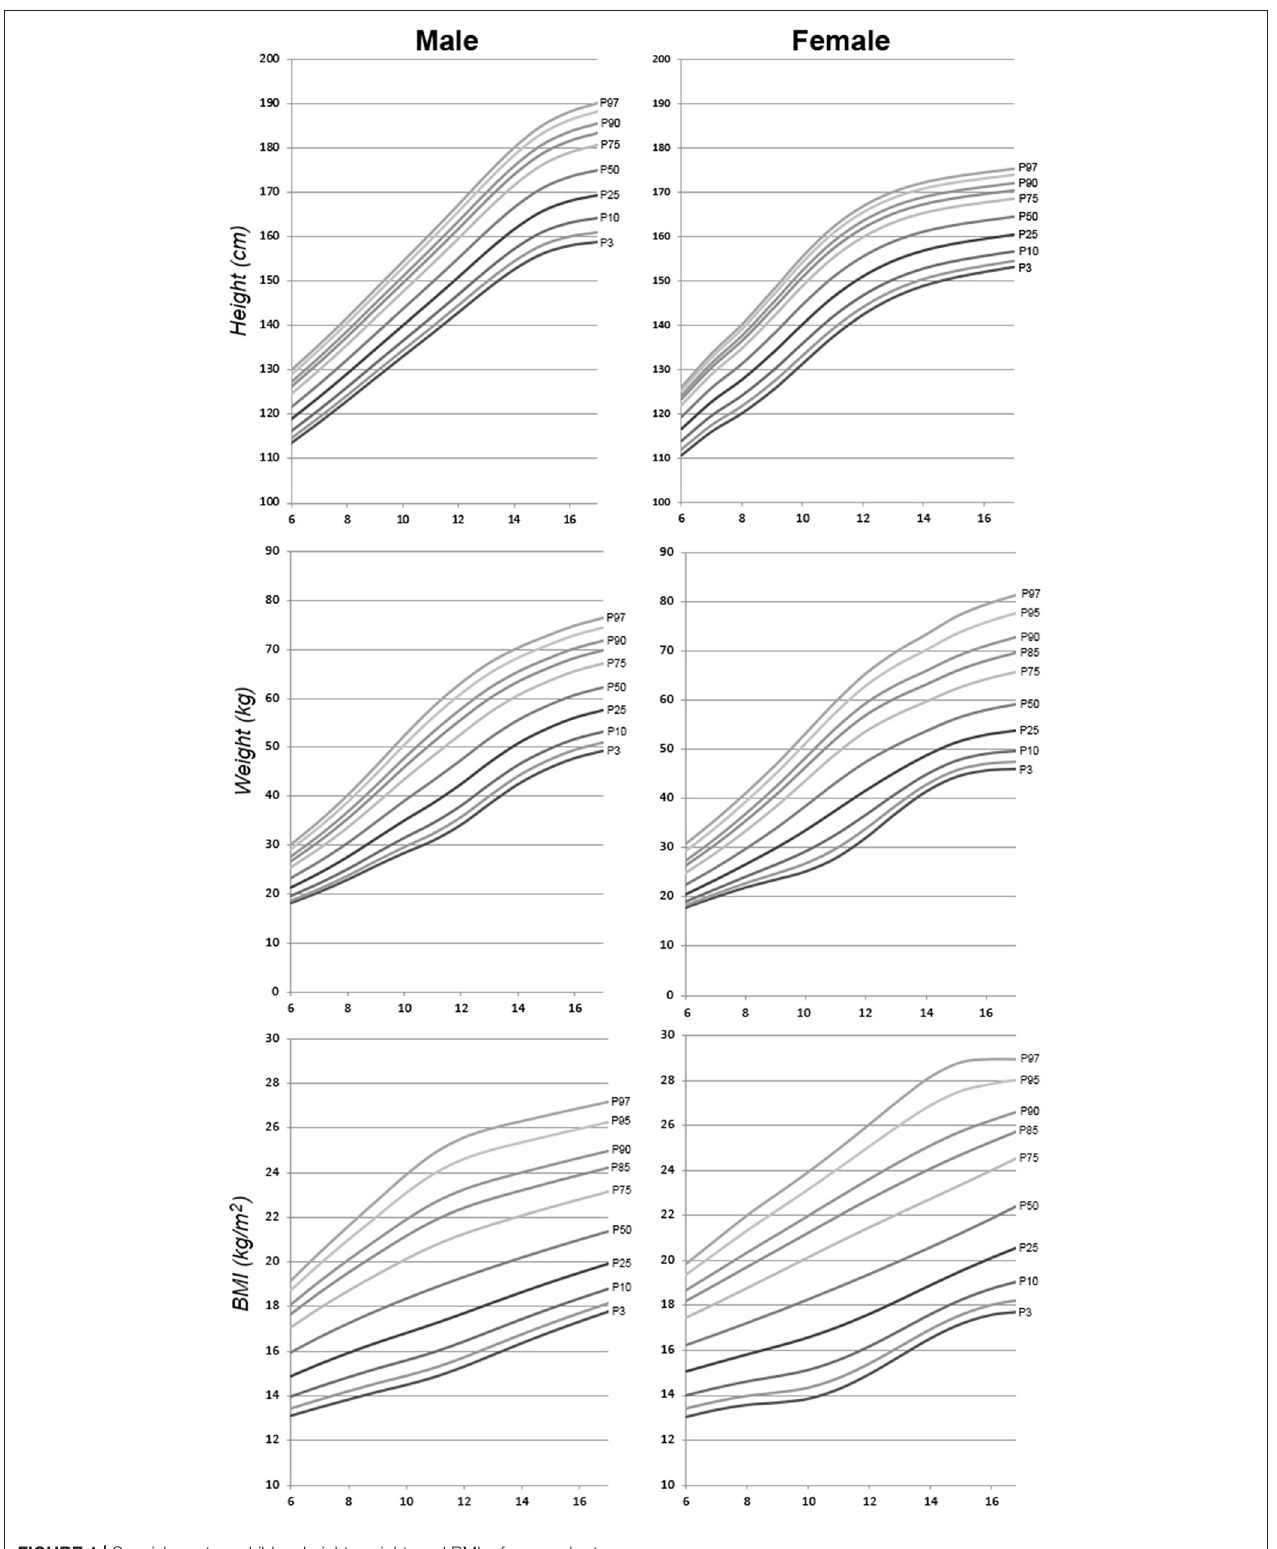
FIGURE 1 | Spanish-eastern children height, weight, and BMI reference charts.